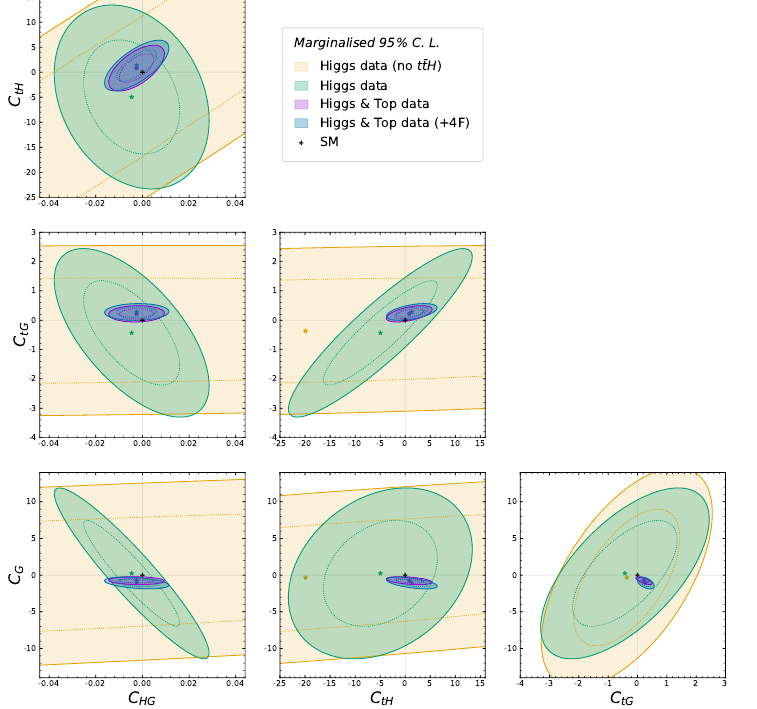
Figure 7 . Constraints on the indicated pairs of operator coefficients at the 95% confidence level, marginalised over the remaining degrees of freedom in the ‘Higgs only’ operator set. The green and mauve shaded areas correspond to combined linear fits to Higgs data and Higgs + top data, respectively. The blue ellipses indicate the marginalised constraints from Higgs + top data after introducing top-quark four-fermion operators into the fit, and the yellow ellipses are obtained from a fit dropping the t ¯ tH